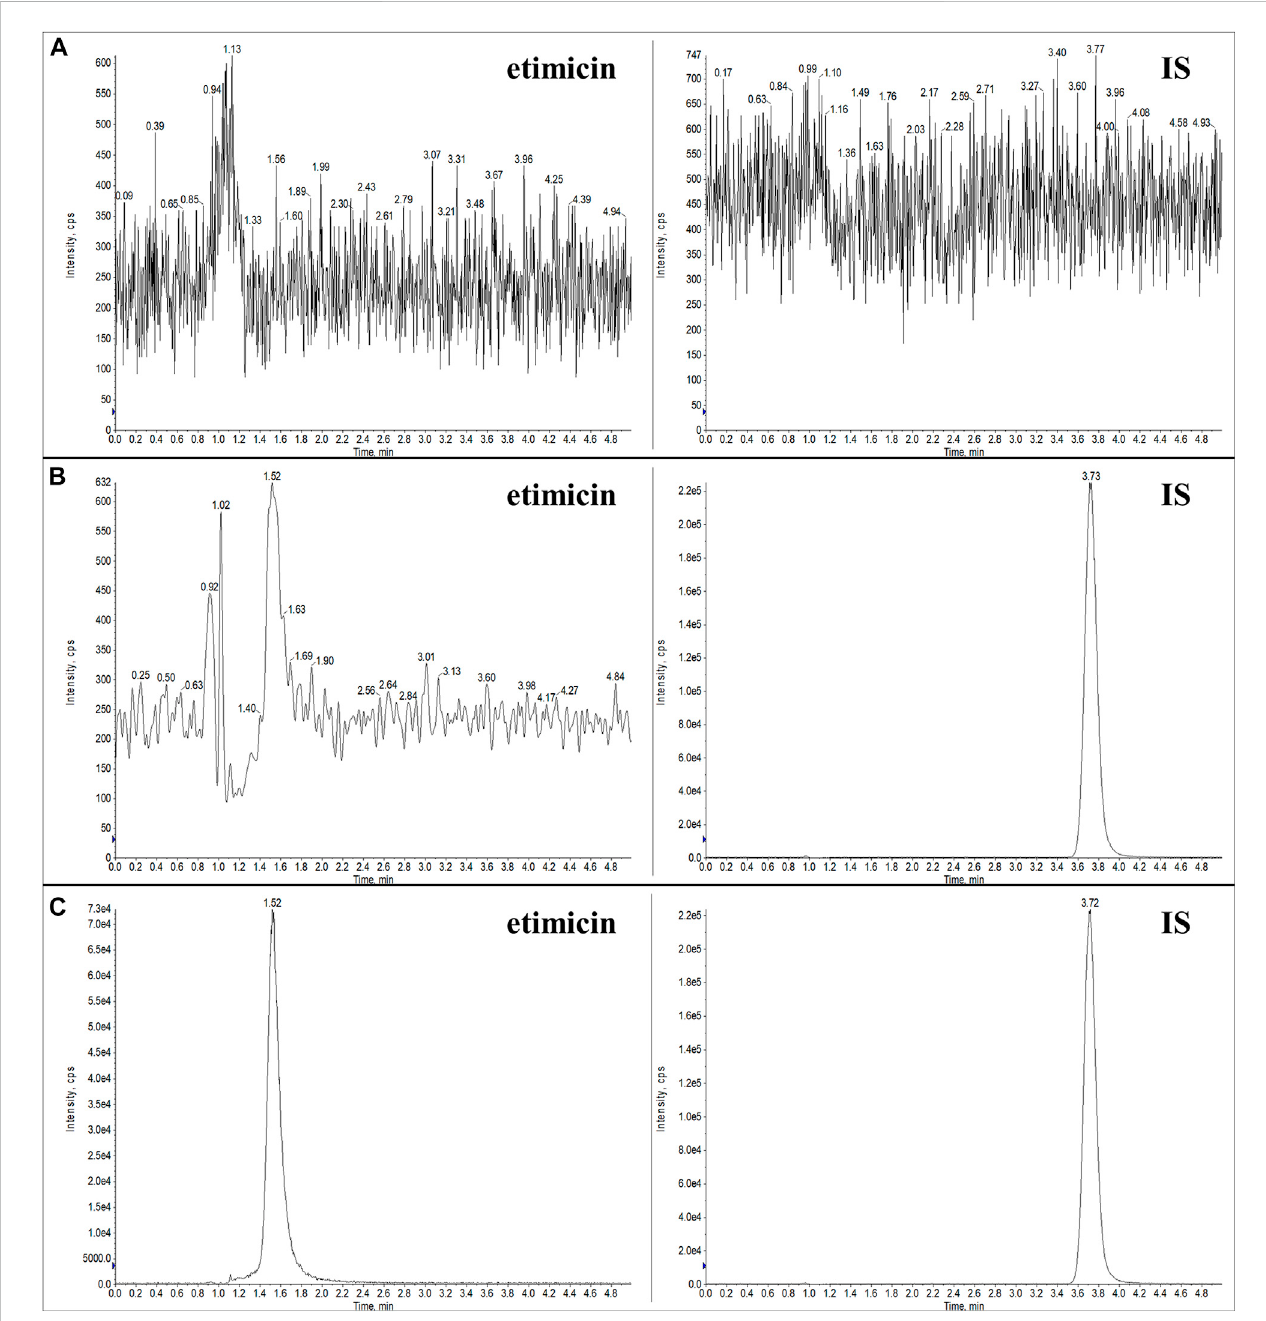
FIGURE 4 Representative LC-MS/MS chromatograms of etimicin and the IS in blank urine (A) , LLOQ urine (B) , and urine sample from Chinese HVs after administration of etimicin (C) . Transitions monitored for quantitation were m/z 478.280 → 191.110 for etimicin and m/z 247.100 → 204.197 for the IS,